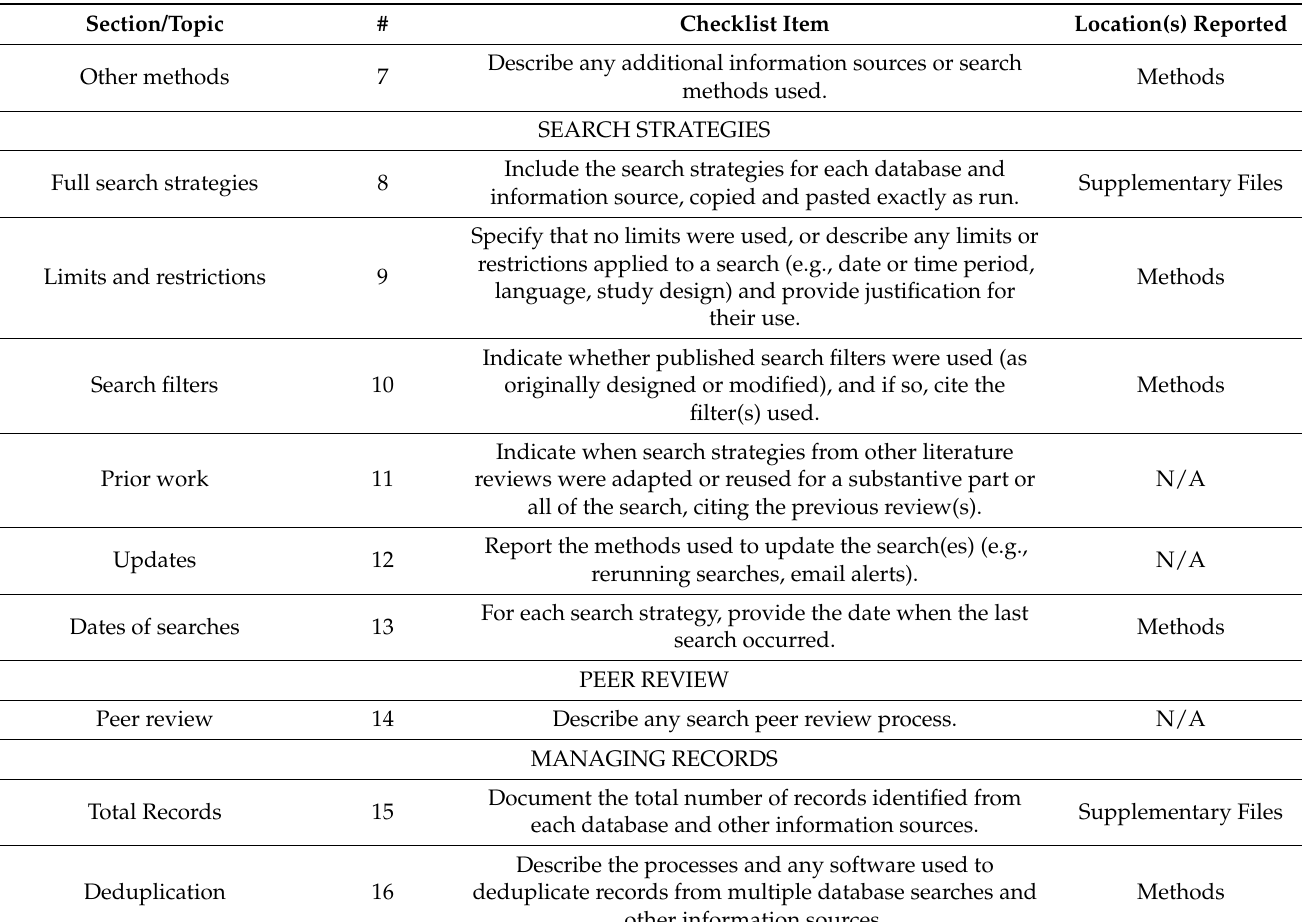
Table A1. PRISMA-S